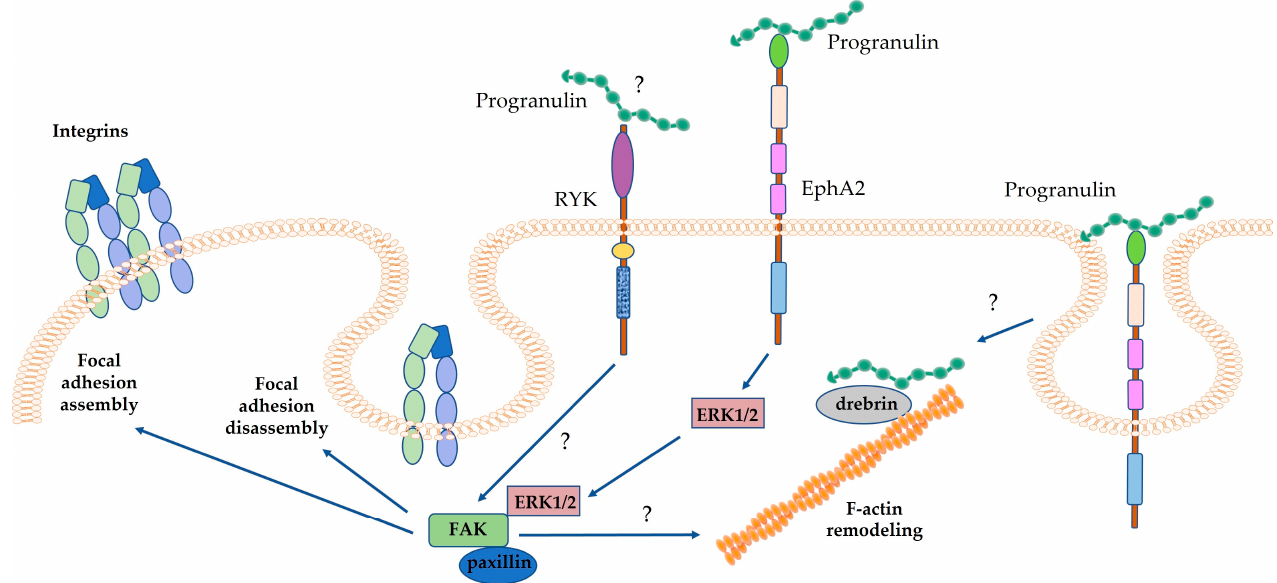
Figure 3. Progranulin modulates FAK activity. In bladder cancer, progranulin-dependent activation of ERK1/2 promotes the formation of a complex containing FAK, paxillin and ERK1/2, thereby promoting cell motility. In addition, in bladder cancer, progranulin interacts with the F-actin-binding protein drebrin, promoting F-actin remodeling. However, the mechanism by which progranulin interacts with drebrin is still unknown and could be dependent on receptor-mediated progranulin internalization. In mesothelioma cells, progranulin modulates the phosphorylation of FAK, affecting the dynamics of focal adhesion assembly/disassembly and F-actin remodeling. RYK action in progranulin-dependent modulation of FAK in mesothelioma is still not well defined.